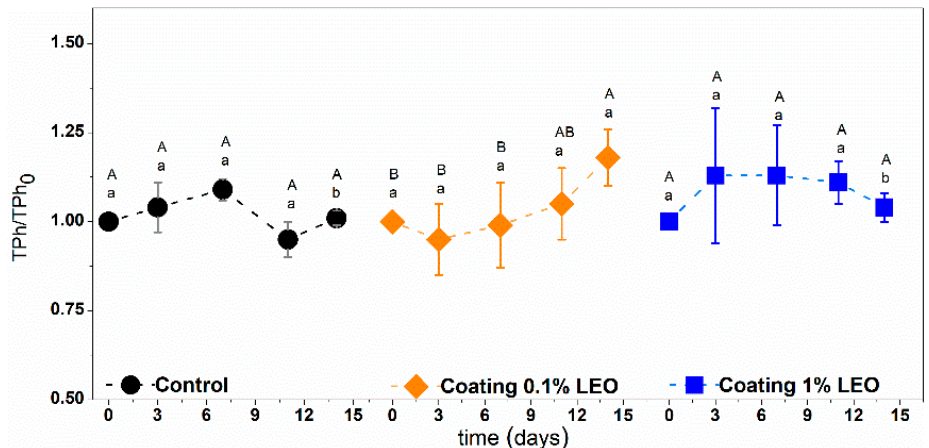
Figure 5. Total phenols ratio of fresh-cut apples with different treatment during storage at 4 °C. Means with the same letters (lowercase: amongst different treatments for the same time; uppercase: for the same treatment during different storage times) are not significantly different according to Tukey’s test ( p > 0.05). Vertical bars indicate standard deviation.